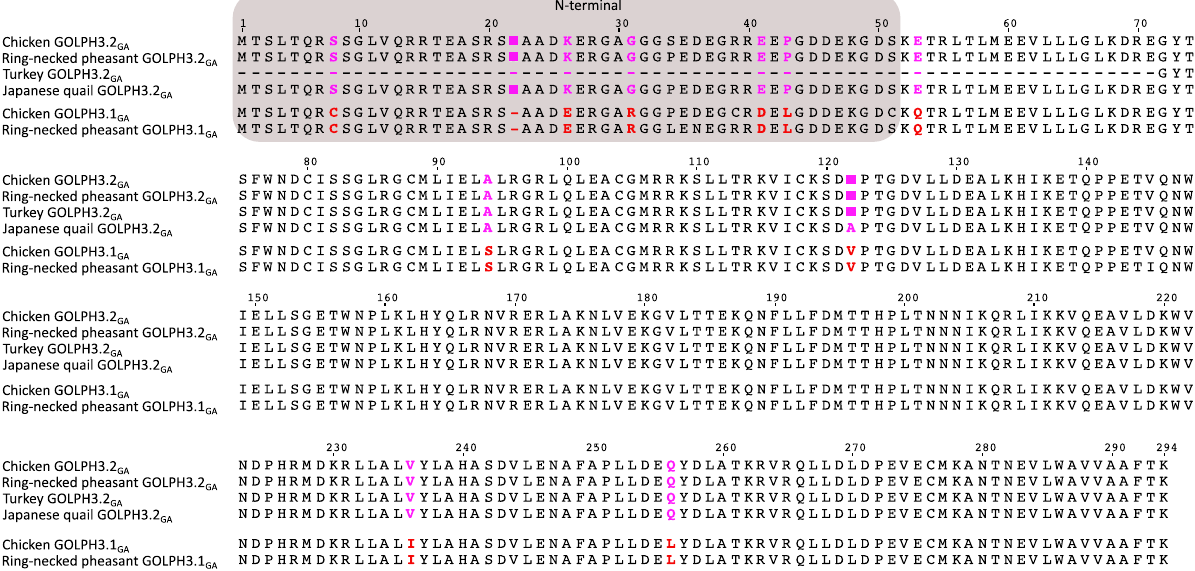
Figure 3. Alignment of Golgi phosphoprotein 3 (GOLPH3) amino acid sequences from chicken ( Gallus gallus ), ring-necked pheasant ( Phasianus colchicus) , turkey ( Meleagris gallopavo ) and japanese quail ( Coturnix japonica ). Amino acids positions that differentiate between paralogs are in pink and red. The N-terminal region of the protein is shaded.